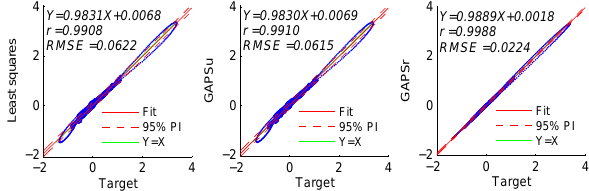
Figure 8. Scatter plots of each inversion method with respect to the waveforms of the target source at all